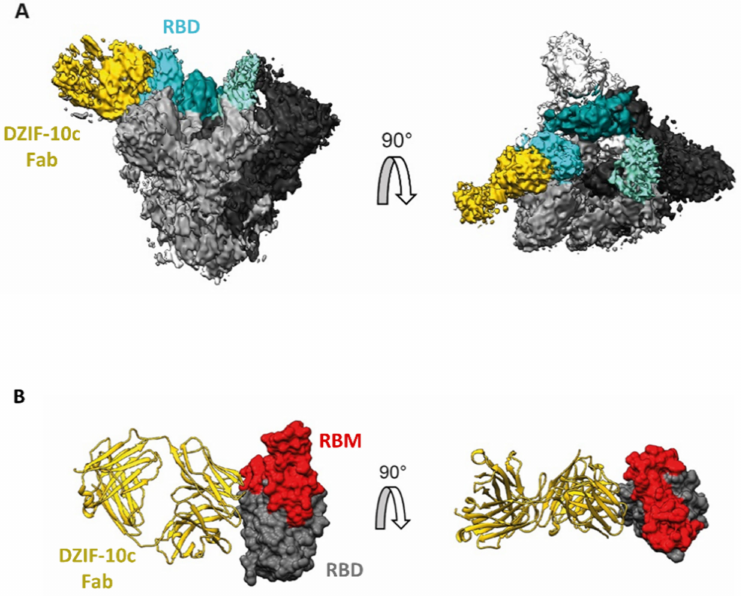
Figure 2. Cryo-EM map of the DZIF-10c Fab/SARS-CoV-2 S complex. ( A ) Cryo-EM map with S protein colored in gray shades (according to the three protomers), density corresponding to the RBDs colored in cyan shades and density corresponding to the Fab fragment colored in yellow. left: side view; right: top view. ( B ) Approximate binding position and angle of DZIF-10c relative to the RBD. DZIF-10c colored in yellow, RBD (PDB-6XDG) colored in grey and receptor binding motif (RBM) on RBD colored in